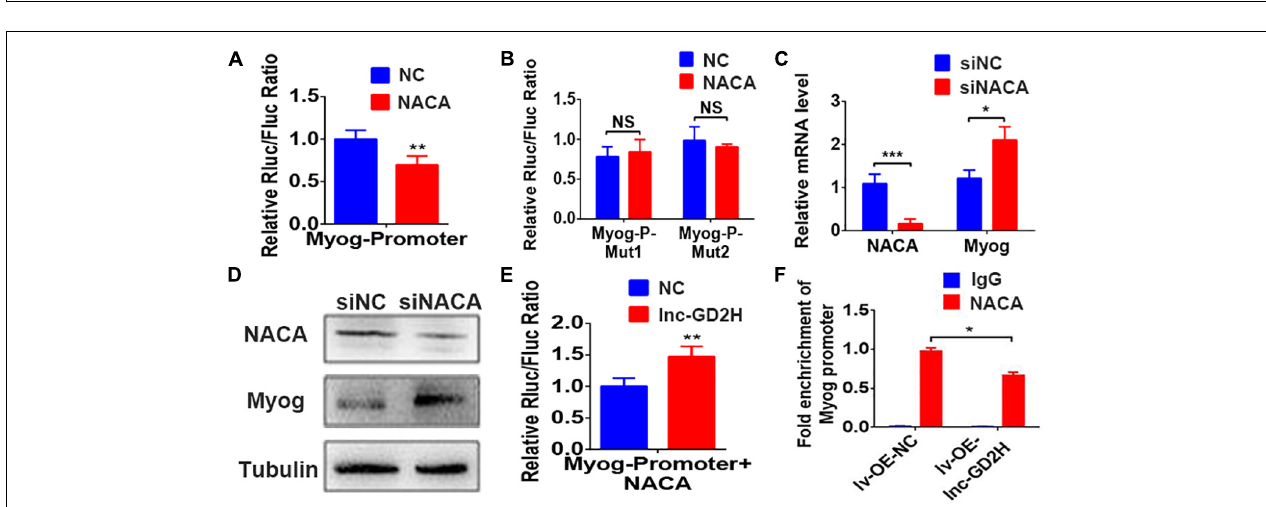
FIGURE 7 | Lnc-GD2H decreased the enrichment of NACA in the Myog promoter. NACA overexpression inhibited the luciferase activity of the wild-type Myog promoter construct (A) but not that of the mutant Myog promoter reporter construct (B) . (C) Myog mRNA and (D) protein levels after NACA knockdown. (E) Luciferase activity upon lnc-GD2H overexpression after NACA and the lnc-GD2H plasmid were transfected together with the Myog promoter. (F) Enrichment of NACA at the promoter region of Myog after lnc-GD2H overexpression. n = 3, * P < 0.05, ** P < 0.01, and *** P < 0.001. NS: